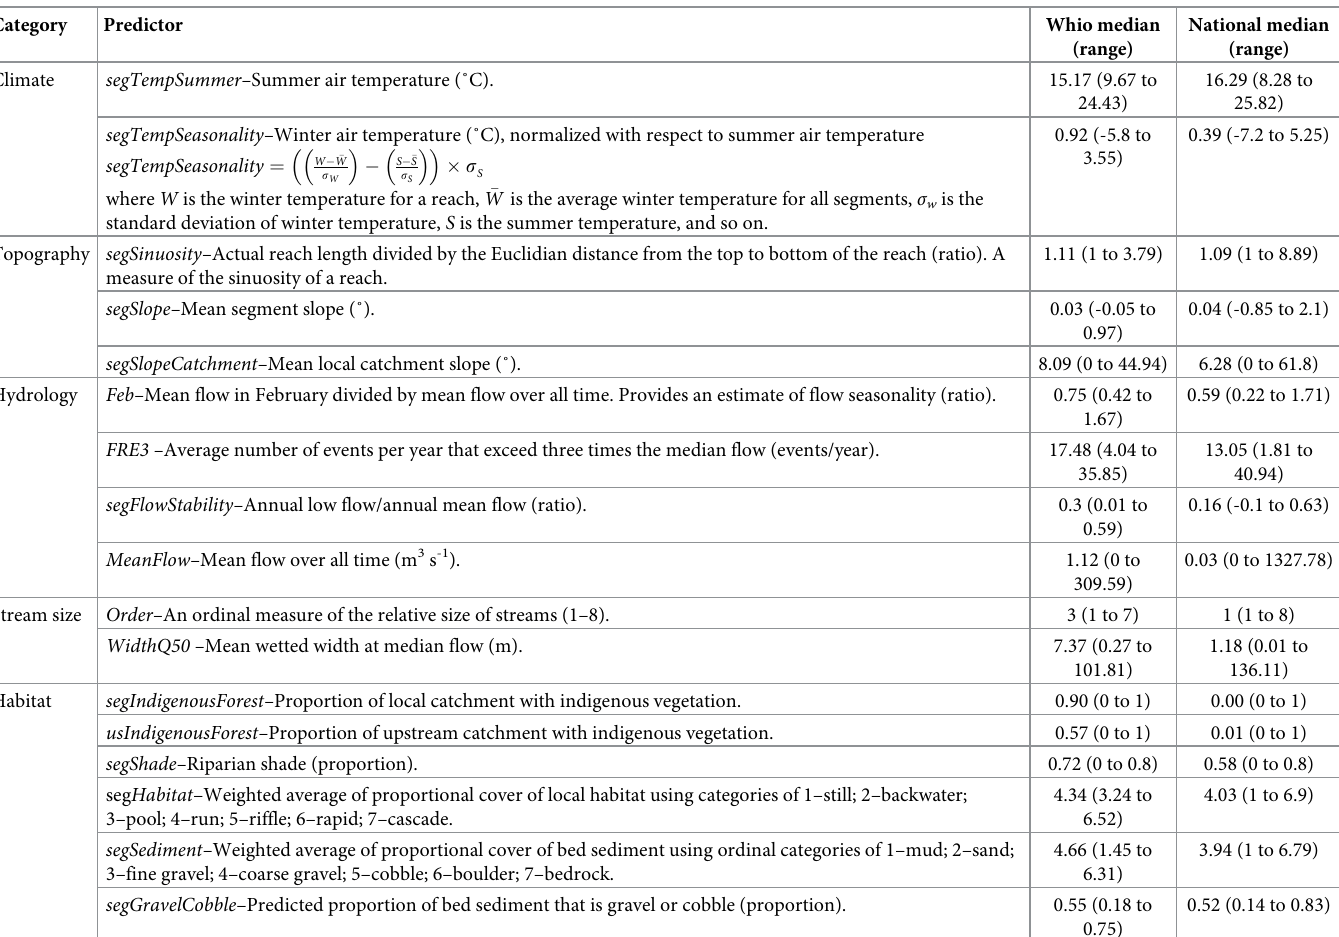
Table 1. Predictors used in a boosted regression tree analysis to predict the relative likelihood of occurrence (RLO) for whio across New Zealand. Category Predictor